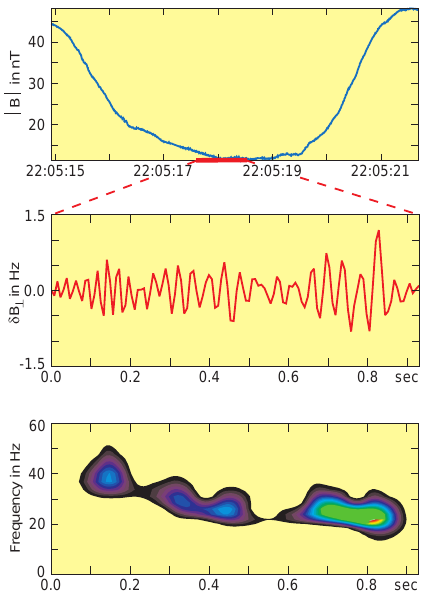
Fig. 3. Mirror mode trough, embedded lion roar waveform, and right-hand polarized wavelet